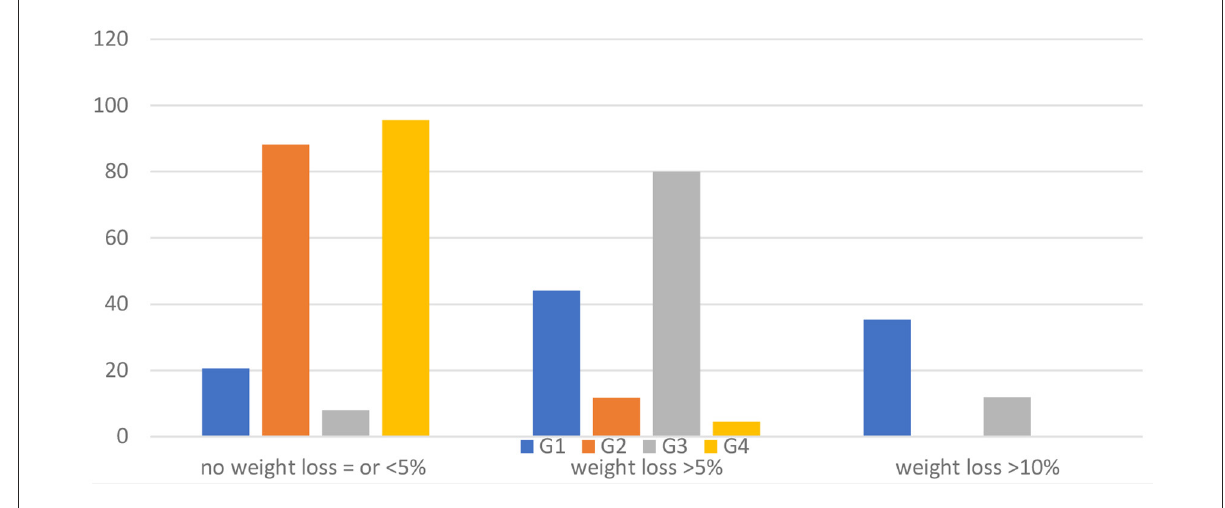
FIGURE3 Percentage of weight change at the 12-month follow-up (T1) in the four groups compared to entry in the study